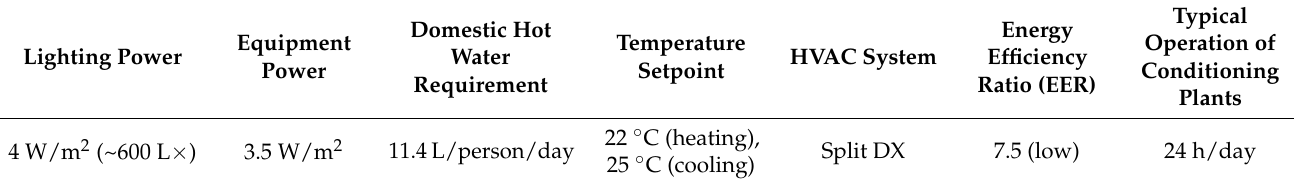
Figure 4. Operational schedules of the selected case. Table 4. Operational parameters of the case